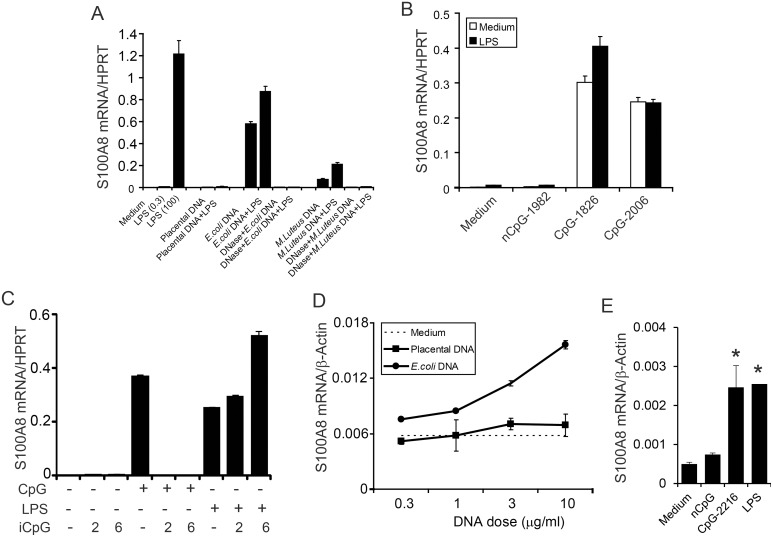
Induction of S100A8 mRNA in macrophages by E. coli DNA, M. luteus DNA, and synthetic CpG-ONDs.(A) RAW 264.7 macrophages were incubated with E. coli DNA (3 µg/ml) or M. luteus DNA (3 µg/ml) ±0.3 ng/ml LPS. Controls include placental DNA (3 µg/ml) ± LPS (0.3 ng/ml), Turbo DNase-treated E. coli DNA or M. luteus DNA ± LPS (0.3 ng/ml). RAW cells were also stimulated with two doses of LPS alone as positive controls (0.3 or 100 ng/ml). (B) RAW cells were untreated (medium) or treated with a synthetic non-CpG-containing OND 1982 (nCpG), a murine-oriented CpG-containing ODN (CpG-1826), or a human-oriented CpG-containing ODN (CpG-2006) (all 3 µM final concentration) ± LPS (0.3 ng/ml). (C) medium control, CpG-1826 (3 µM) or LPS (20 ng/ml) were co-stimulated with inhibitory CpG ODN 2088 (iCpG) 2 or 6 µM. (D) Elicited murine macrophages were untreated or stimulated with human placental DNA or E. coli DNA at the indicated concentrations. (E) Human monocyte-derived macrophages stimulated with 3 µM of nCpG or CpG-2216; LPS (20 ng/ml) was positive control. Combined data from 3 independent experiments are presented as the mean ± SD (*, p<0.05). All treatments were for 24 h before cell harvest. Total RNAs were extracted and S100A8 mRNA quantitated by real-time RT-PCR and normalized to the house-keeping genes (murine HPRT was used as endogenous control for A, B and C; murine β-actin for D; human β-actin for E). All data, except E, are represented as means (relative to the HPRT or actin mRNA levels) ± SD of duplicate measurements and are representative of at least 3 experiments.